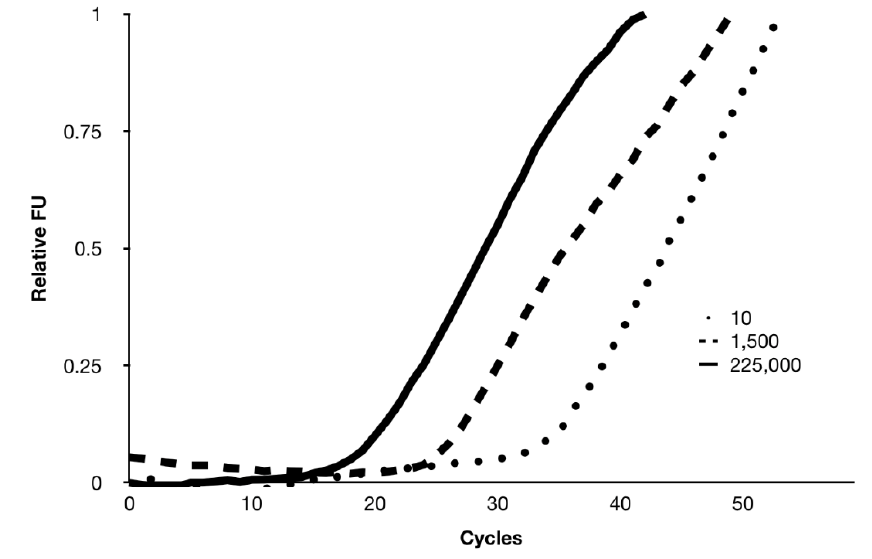
Figure 7. Cytomegalovirus (CMV) polymerase chain reaction (PCR) assay using a prototype DMF cartridge. Successful amplification of CMV (10, 1500, and 225,000 copies / µ L) is achieved within 5 min. FU: fluorescence units.